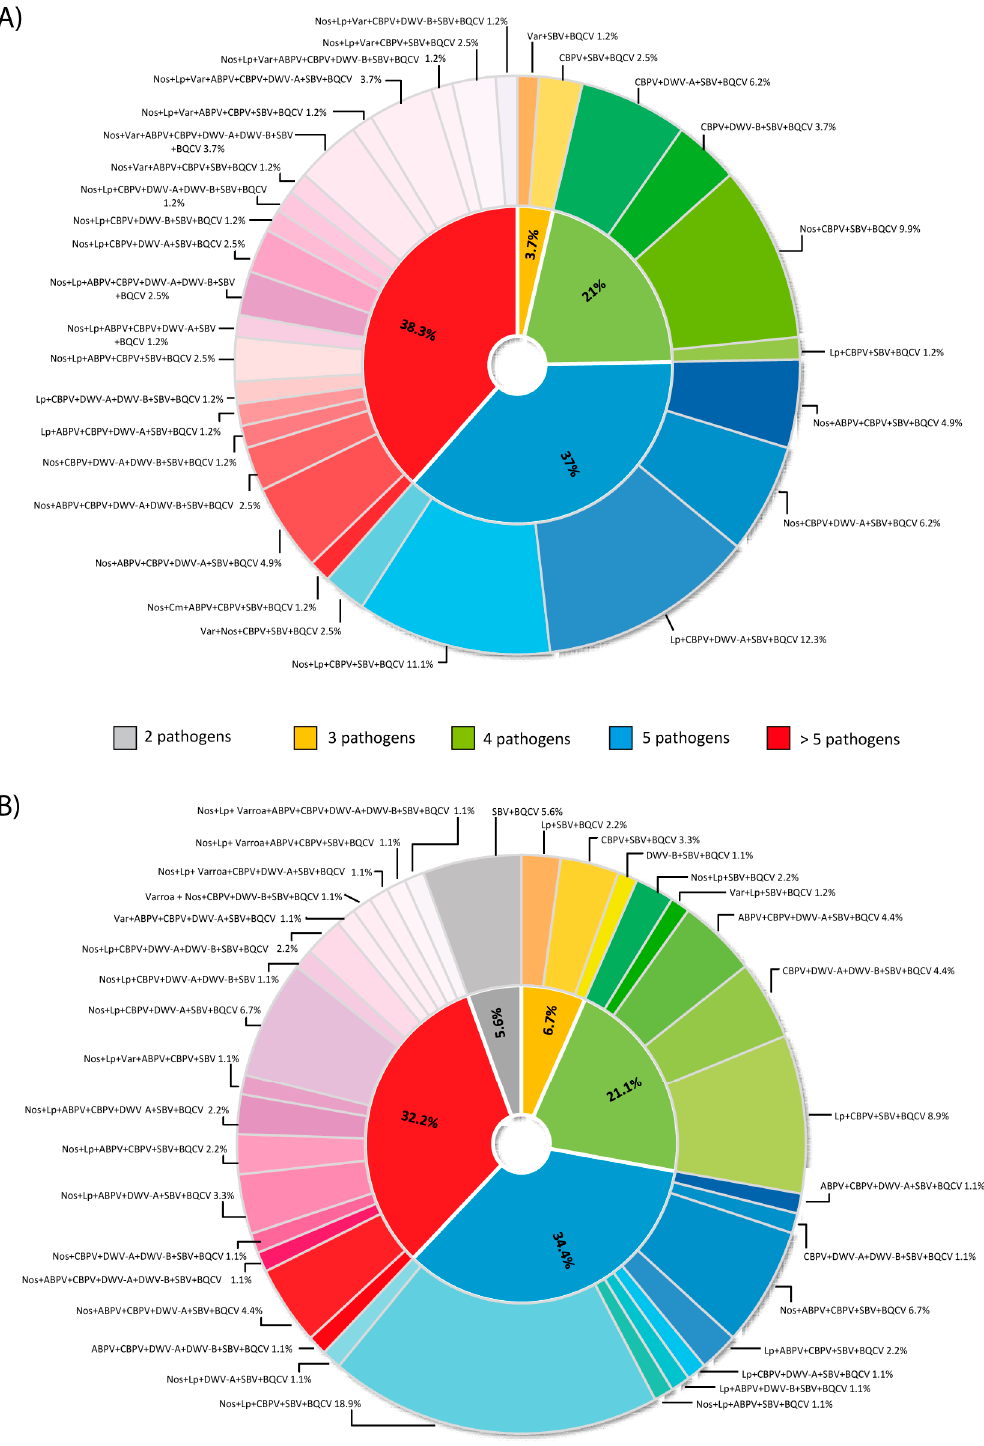
Figure 3. Percentage and type of multiple infections found in all nine apiaries in 2020 ( A ) and 2021 ( B ). Co-infections with 2 pathogens are shown in the shades of grey, with 3 pathogens in the shades of yellow, with 4 pathogens in the shades of green, with 5 pathogens in the shades of blue, and with 6 pathogens or more in the shades of